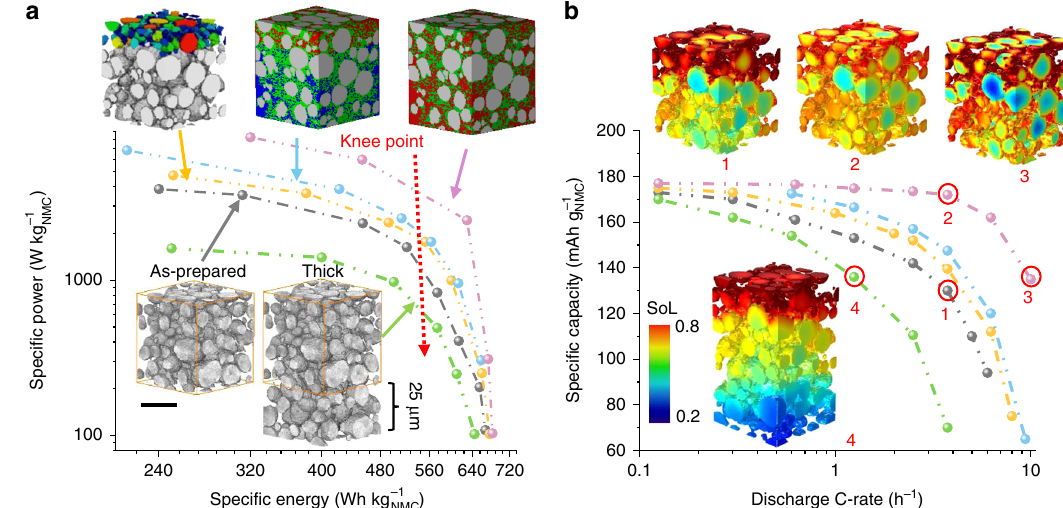
Fig. 8 Comparison of the simulated electrochemical performance for different electrode designs. a Ragone plot comparing the speci fi c power vs. energy for a variety of electrode microstructures in lithium metal half-cell (grey: 50 μ m electrode; green: 75 μ m electrode; yellow: graded particle; light blue: graded pore; pink: high porosity). The speci fi c energy is obtained by integrating the discharge curve to the cut-off voltage (3 V) and the speci fi c power is obtained by dividing the speci fi c energy with the total discharge time; b maximum accessible speci fi c capacity as a function of C-rate for different microstructures. The inset fi gures compare the spatial distribution of SoL under different conditions, corresponding to the numbers on the curve respectively. The scale bar in ( a ) represents 20 μ